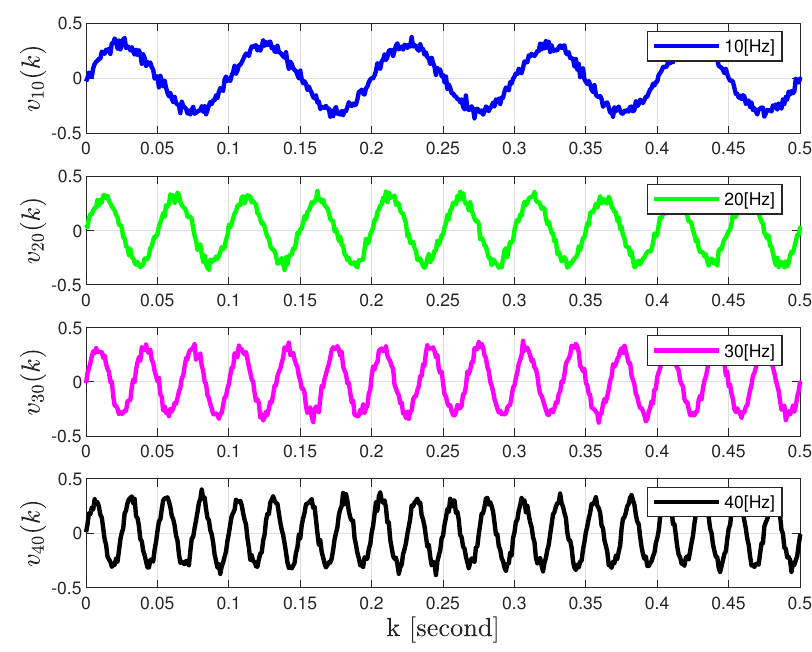
Figure 6. Sinusoidal voltage signal measurement.